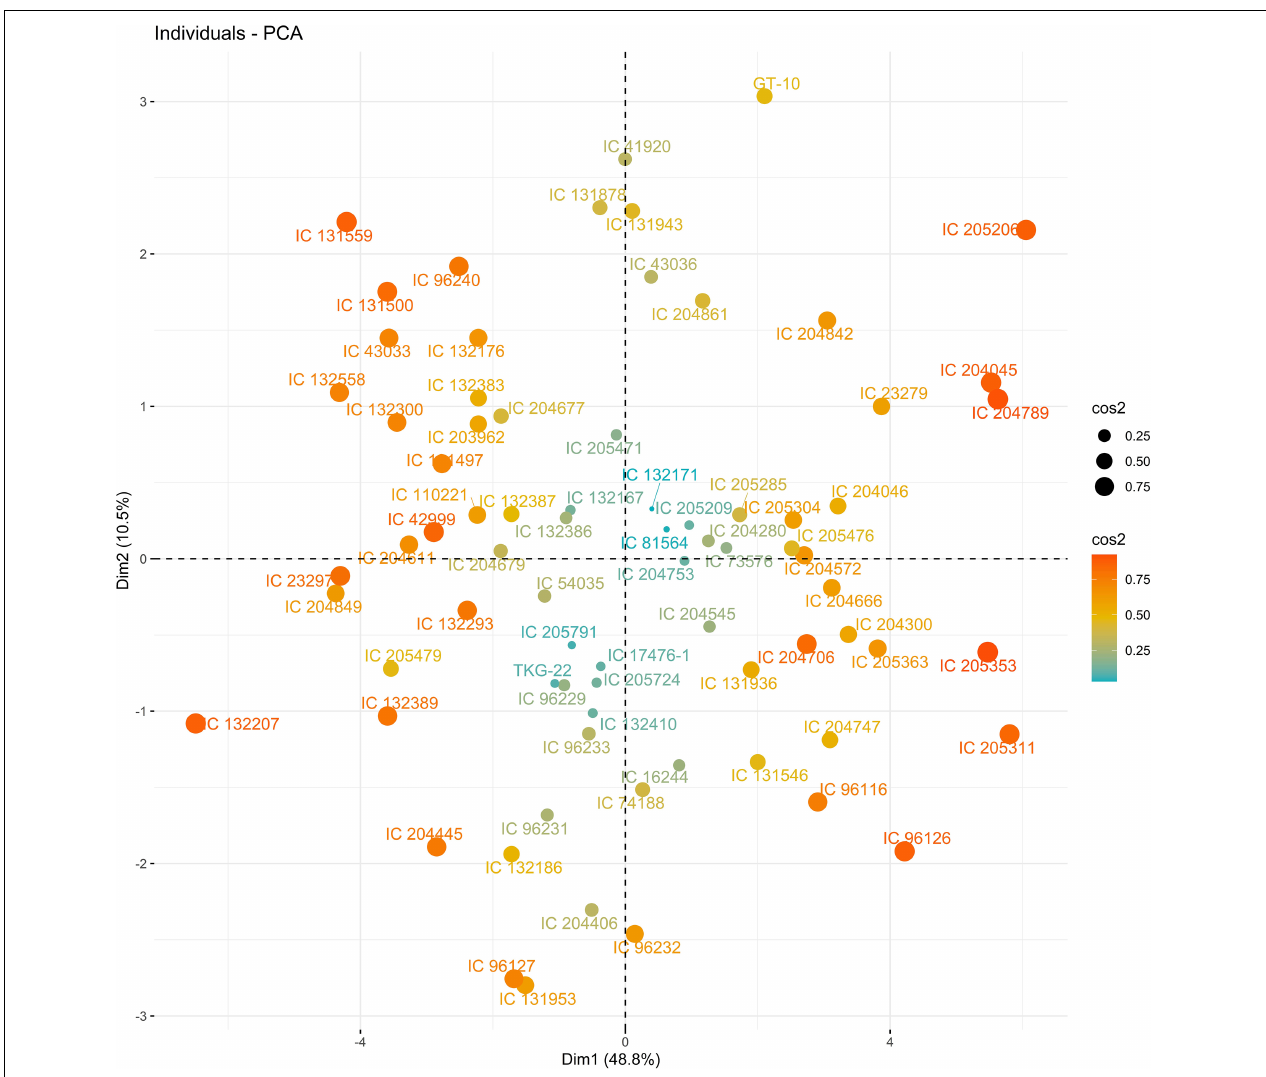
FIGURE 6 | Principal scatter plot of the first two principal component analysis (PCA) of 76 sesame genotypes during year 2018 under WS